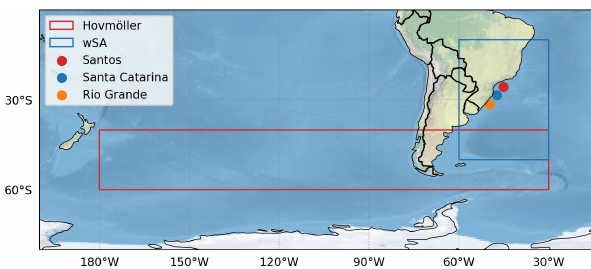
Figure 1. Domains and moorings used in this study: the wSA is the ocean area inside the blue rectangle; red rectangle shows the region used to calculate the Hovmöller diagrams (Sect. 3); circles show the approximate position of PNBOIA moorings used to evaluate the ERA5 swh